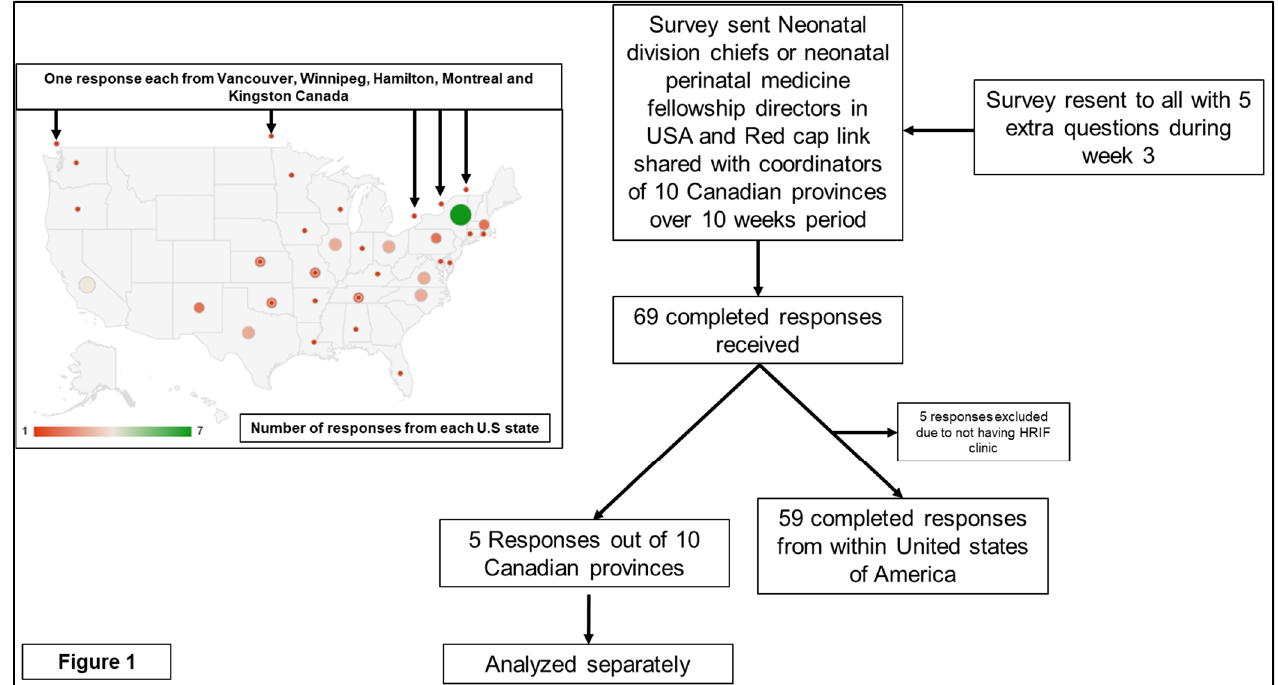
Figure 1. Geographical location and response breakdown